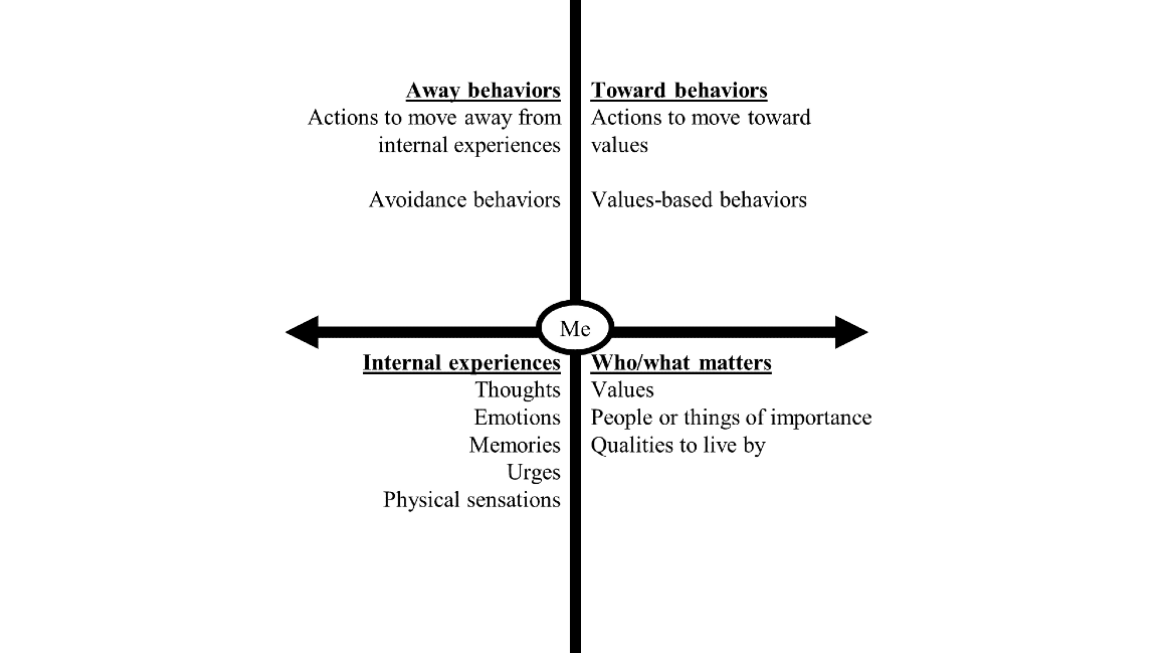
Figure 1. The acceptance and commitment therapy (ACT) matrix. The ACT matrix encourages awareness of one’s values, internal experiences, and the function of one’s behaviors. The top two quadrants are observable behaviors, while the bottom two quadrants are internal experiences and not observable to others. The middle circle signifies the ability to notice each of these domains, categorizing all quadrants as part of a person’s